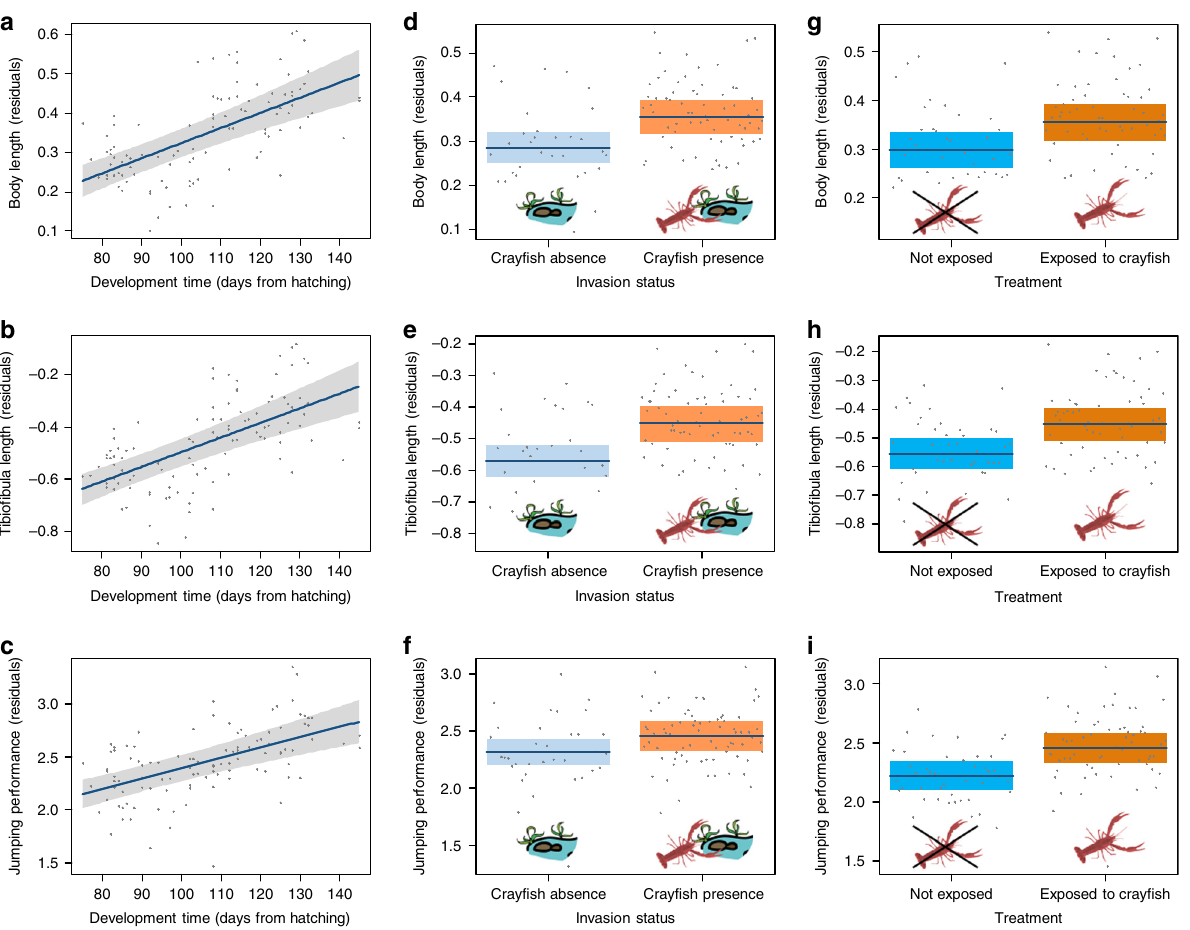
Fig. 3 Factors affecting post-metamorphic traits of froglets. Plots are conditional partial residual plots showing the in fl uence on froglet body length, tibio fi bula length and maximum jumping distance of development time ( a – c ), invasion status of the population ( d – f ) and cray fi sh exposure during rearing ( g – i ). Bold blue lines represent the average value obtained using mixed models, while shaded areas represent 95% con fi dence bands. n = 110 froglets. Source data are provided as a Source data fi